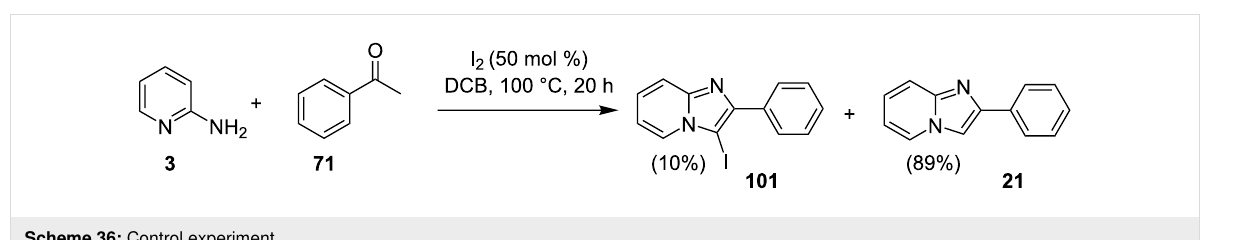
Scheme 36: Control